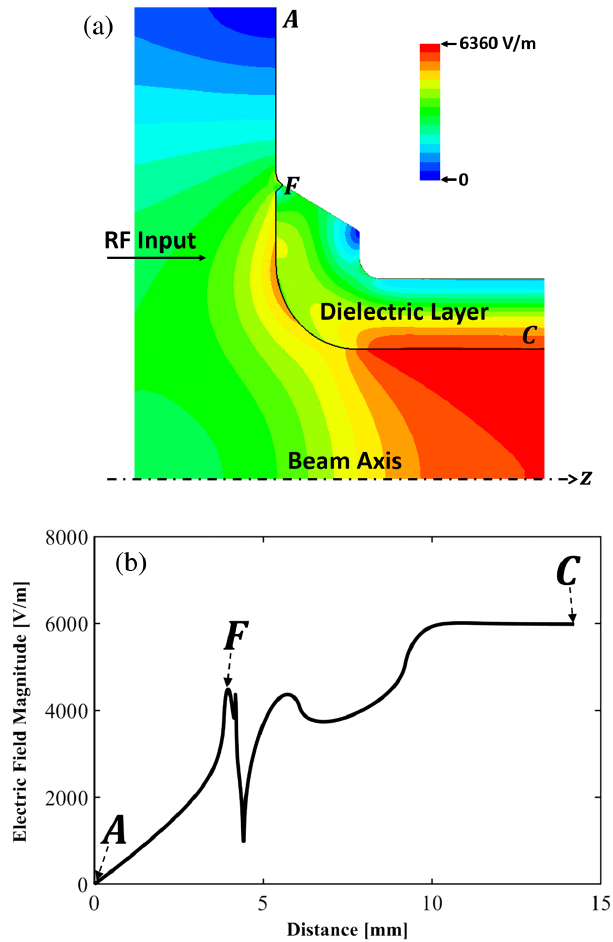
FIG. 5. (a) Electric field distribution for the compact dielectric matching section with a chamfered corner. (b) Electric field magnitude along path AFC which denotes a section of lines and arcs connected by the points A , F , and C , as shown in (a), where the distance of point A is taken as 0